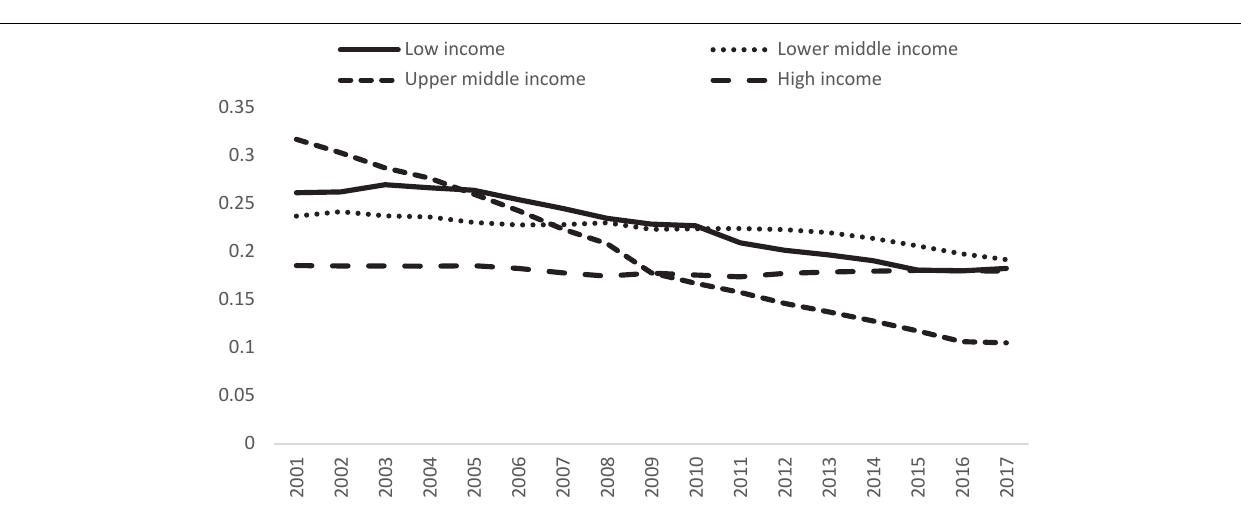
FIGURE 5 | Gini coefficients for different income groups, 2001 to 2017. Source: Authors’